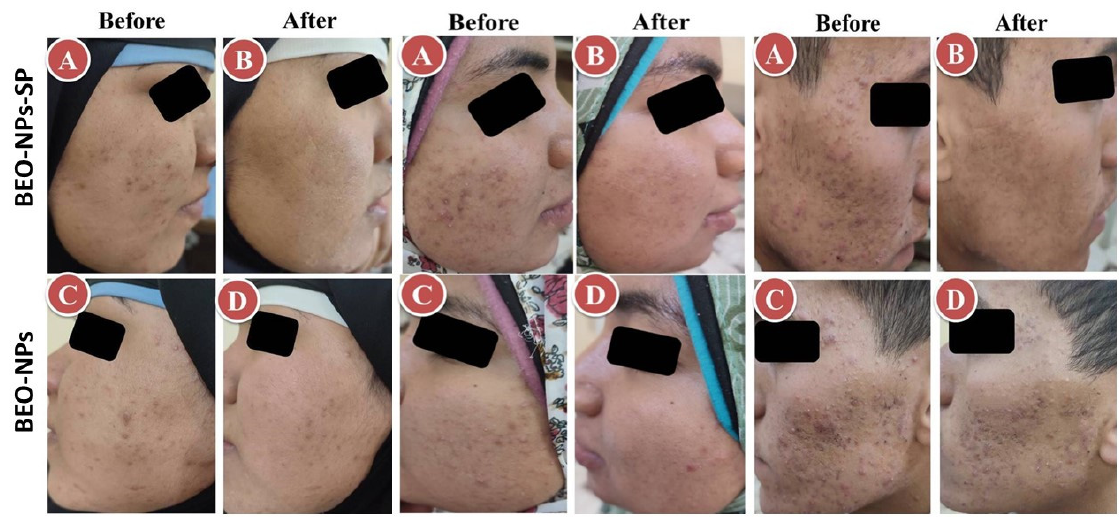
Figure 6. Representative patients receiving the optimized BEO-NPs-SP formulation on the left side of the face (A: Before treatment and B: After treatment) and BEO-NPs formulation on the right side of the face (C: Before treatment and D: After treatment), showing better anti-acne effect of the latter manifested by better reduction in the number of acne lesions. Abbreviations: BEO: bergamot essential oil, NPs: nano-phytosomes, and SP: spironolactone